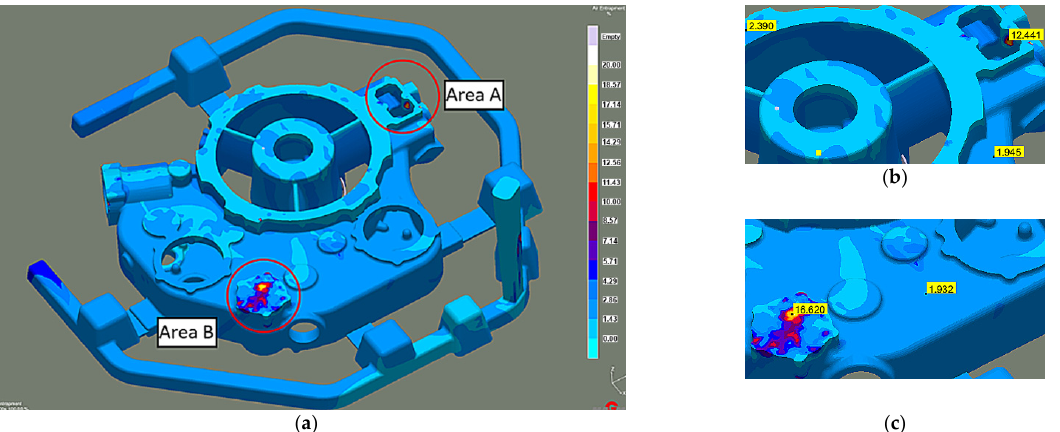
Figure 5. Stage 1 Liquid metal-air entrapment-100% of mold filling: ( a ) whole casting; ( b ) area A; ( c ) area B.